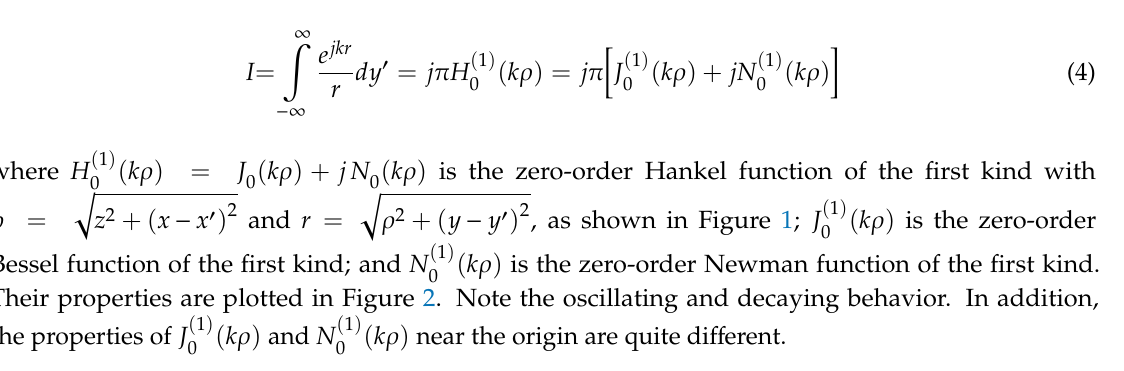
Figure 2. Plots of Hankel function: ( a )